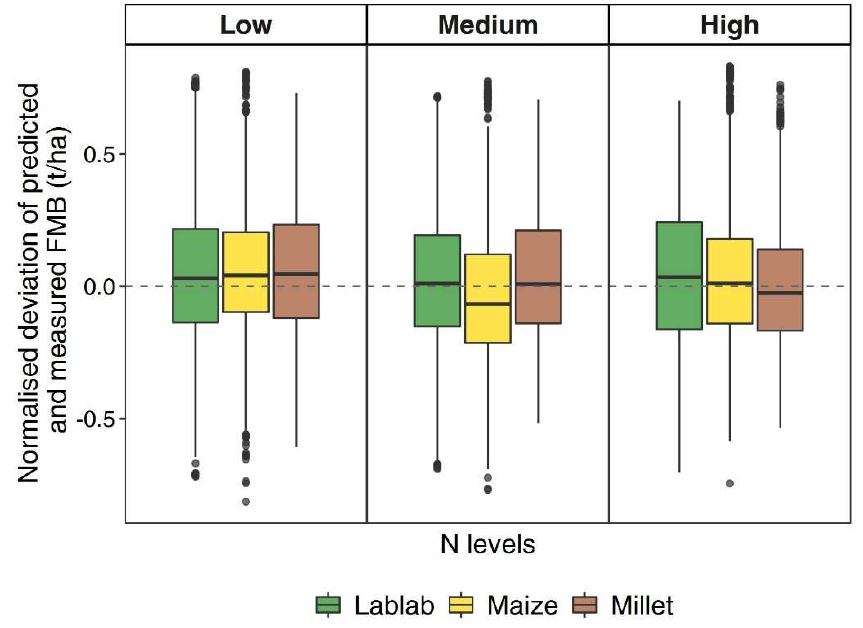
Figure 7. Normalised deviation between predicted and measured biomass for lablab, maize, and finger millet at three levels of N application (low, medium and high). Predictions were based on the Generalised model. Values were averaged over 11 sampling dates (2016–2018) and two levels of water supply (i.e., rainfed and irrigated).